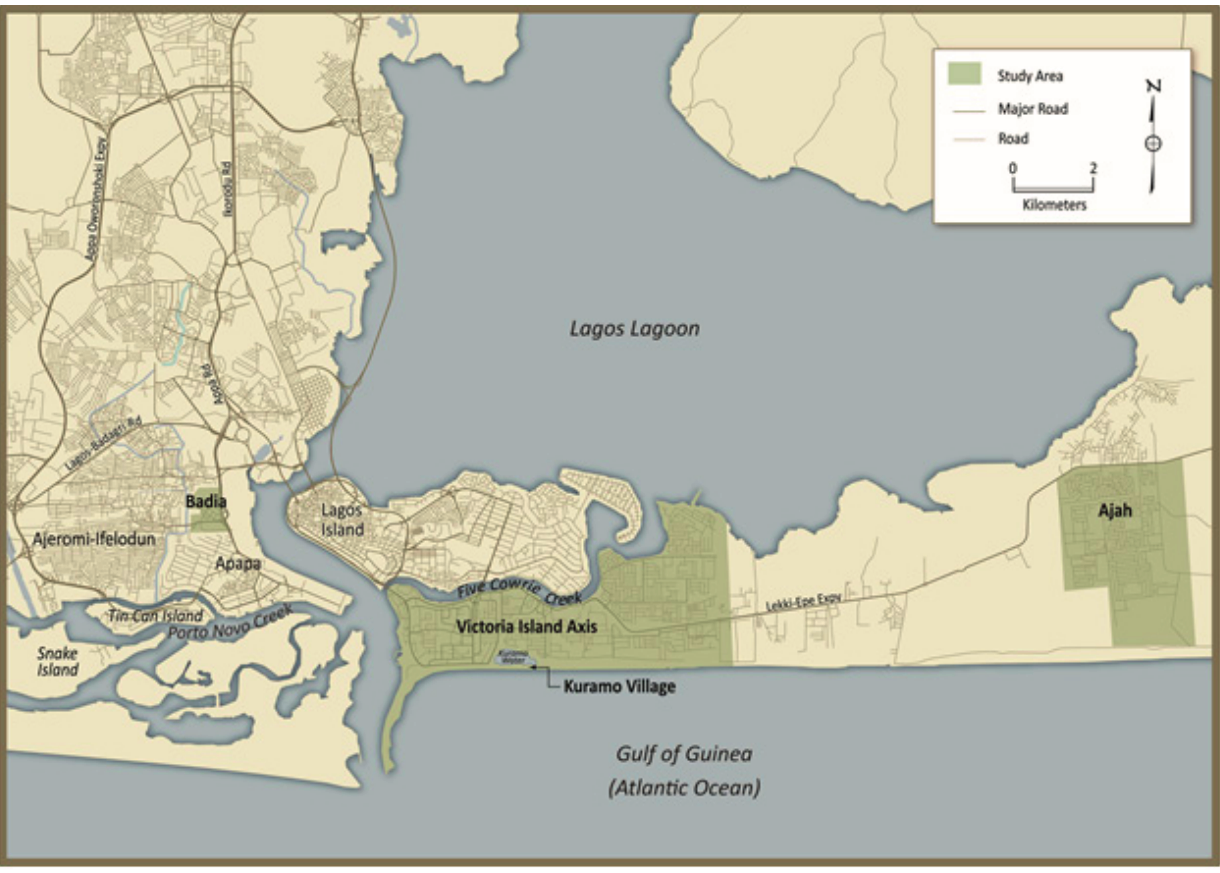
Figure 1. Map of Study